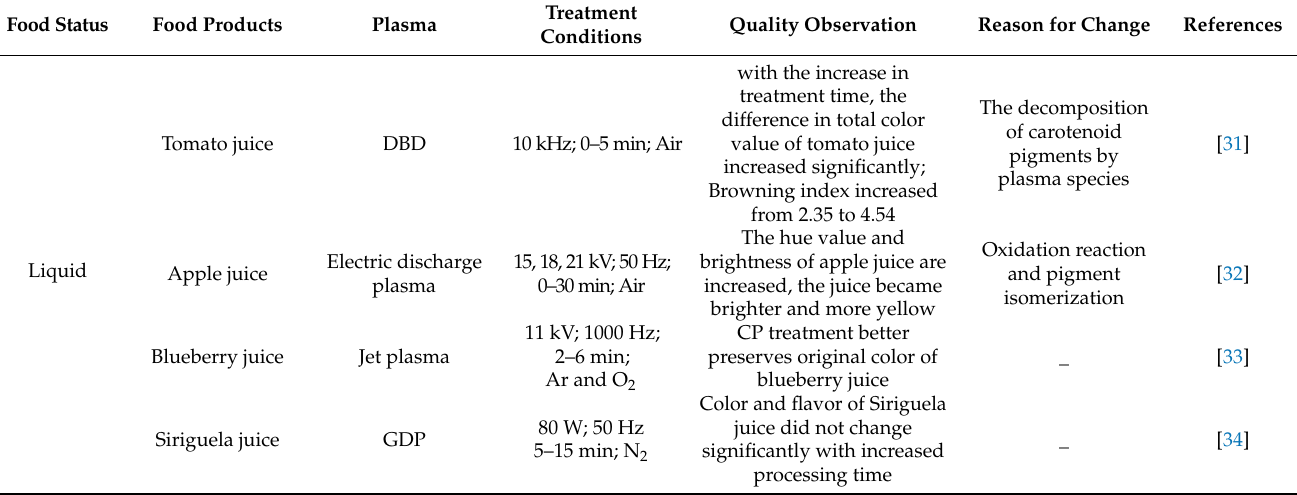
Table 1. Effect of cold plasma treatment on organoleptic properties of various food